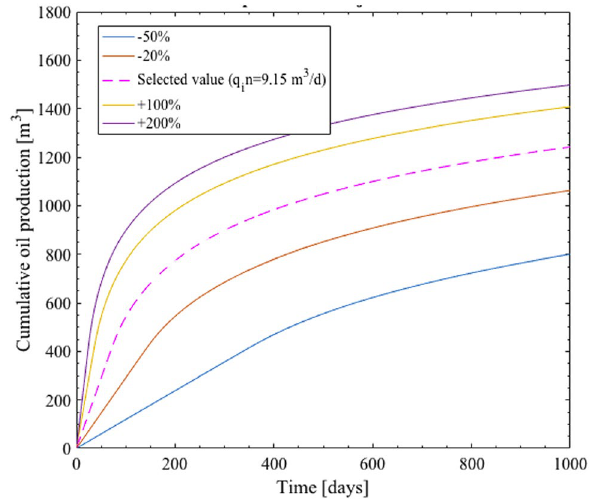
Fig. 10 Variation of cumulative oil production with applied water flooding rate ( q in )